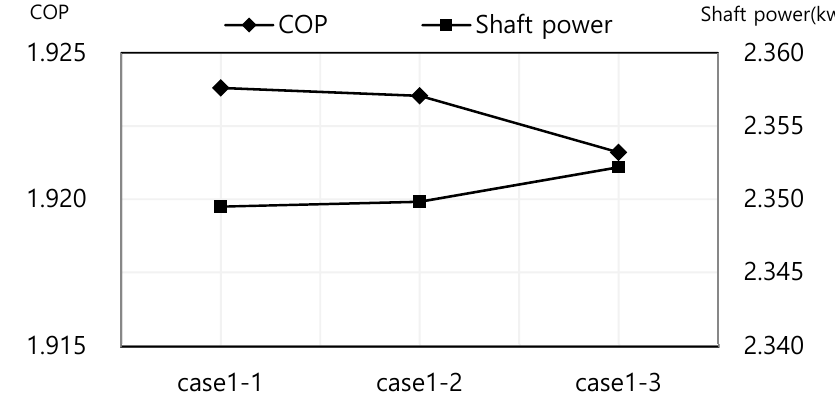
Figure 7. Air blower axial power and COP changes with length.